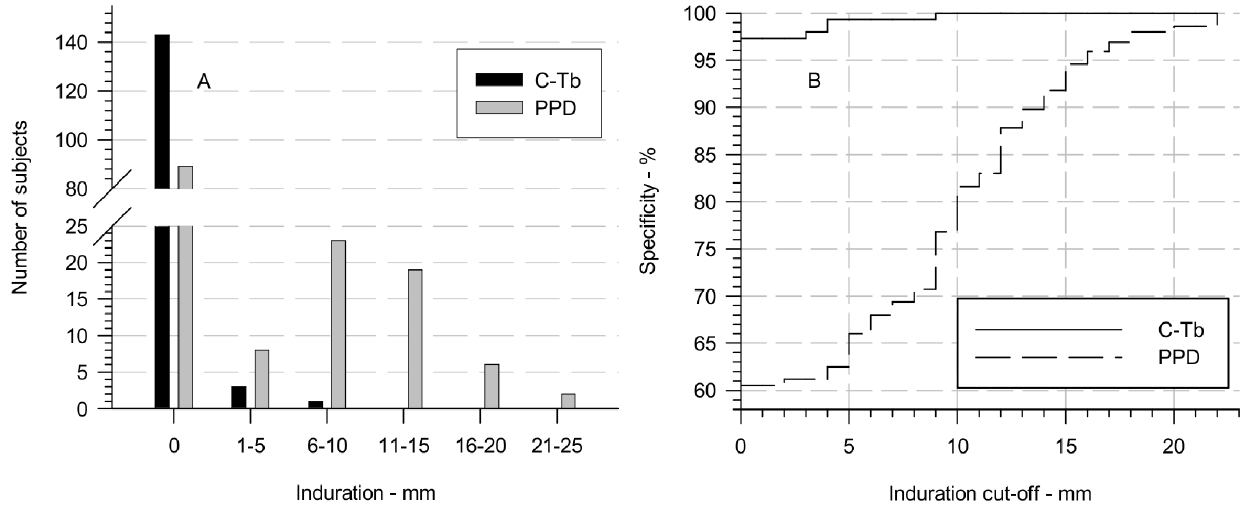
Figure 6. Distribution of induration responses and specificity of C-Tb and PPD in healthy BCG-vaccinated adults. The induration responses 2–3 days after testing with 0.1 m g C-Tb (black bars) and 2 TU PPD RT 23 SSI (grey bars) are shown in panel A. The resulting specificity of C- Tb (solid line) and PPD RT 23 SSI (broken line) as a function of cut-off is shown in panel B. N: 147.